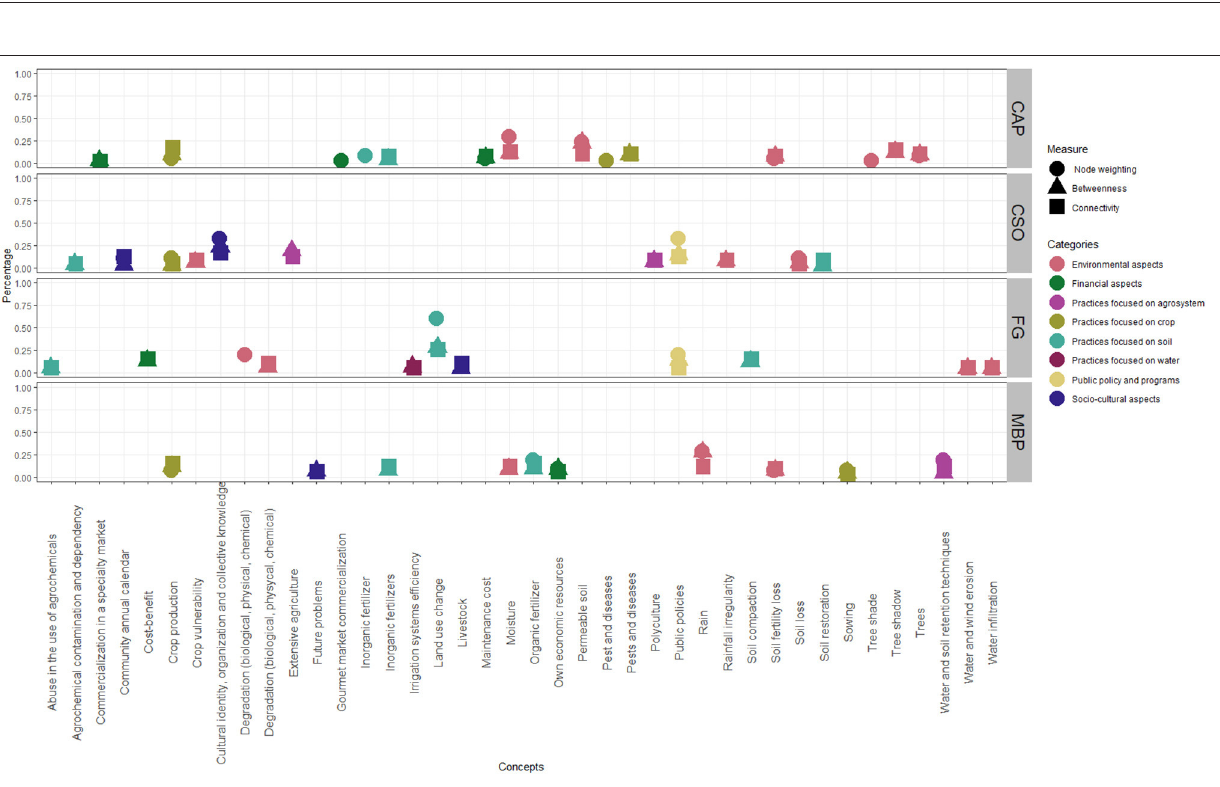
Frontiers in Sustainable Food Systems |